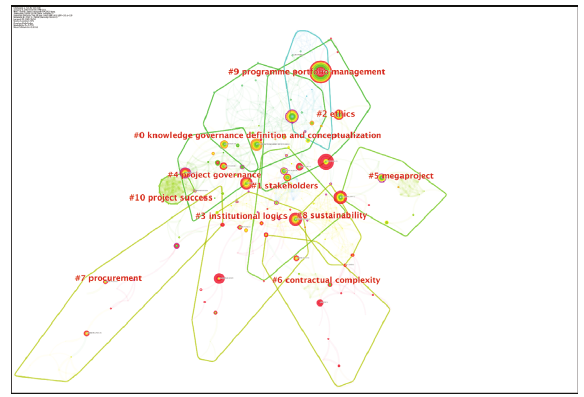
Figure 10: Network of references